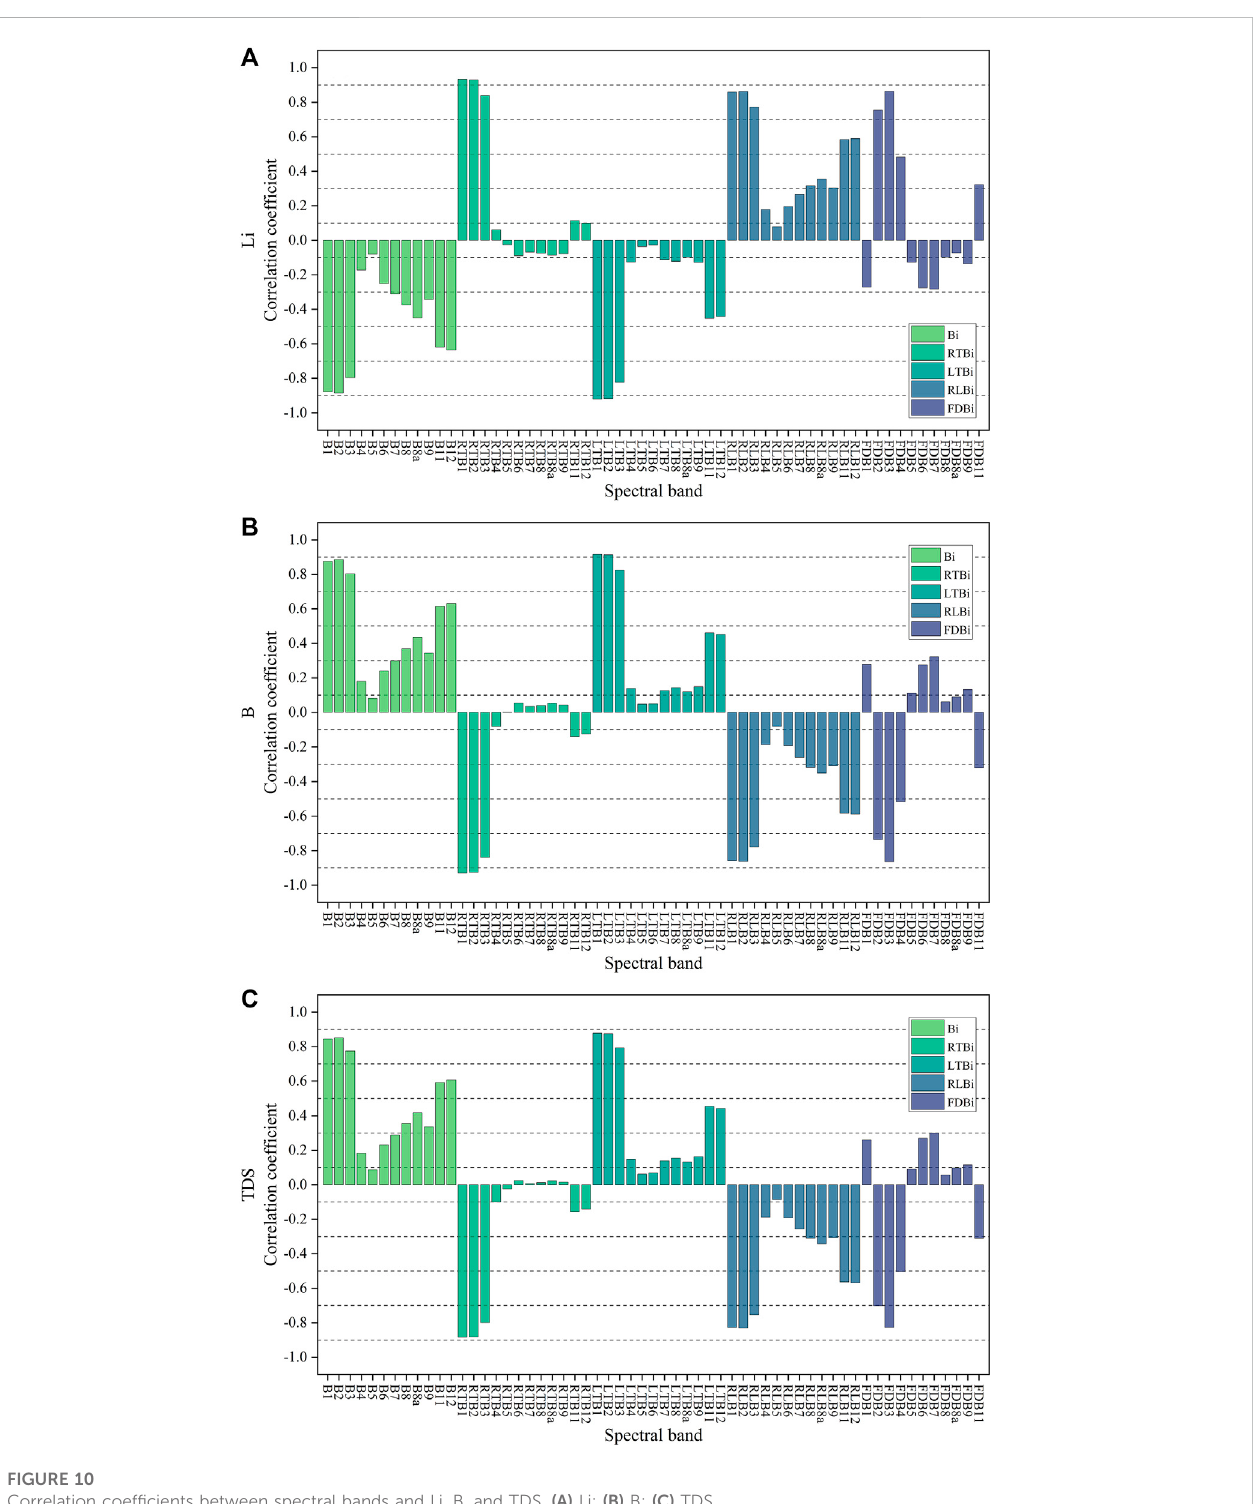
FIGURE 10 Correlation coef fi cients between spectral bands and Li, B, and TDS. (A) Li; (B) B; (C) TDS.